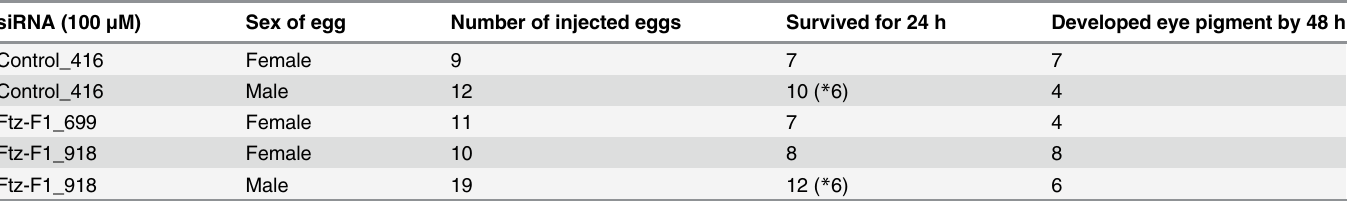
Table 3. Summary of the siRNA microinjection experiment for phenotype observation. Excluding the Control_416 siRNA-injected embryos, all Ftz-F1 siRNA-injected embryos developed abnormally, including failure to shed the outer egg membrane and slow development compared to that observed with nor- mal